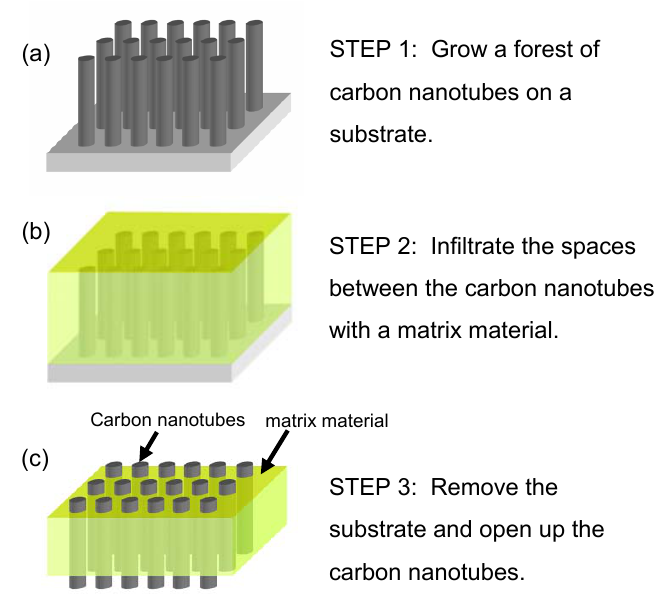
Figure 11. Schematic showing the general approach used to construct isoporous CNT